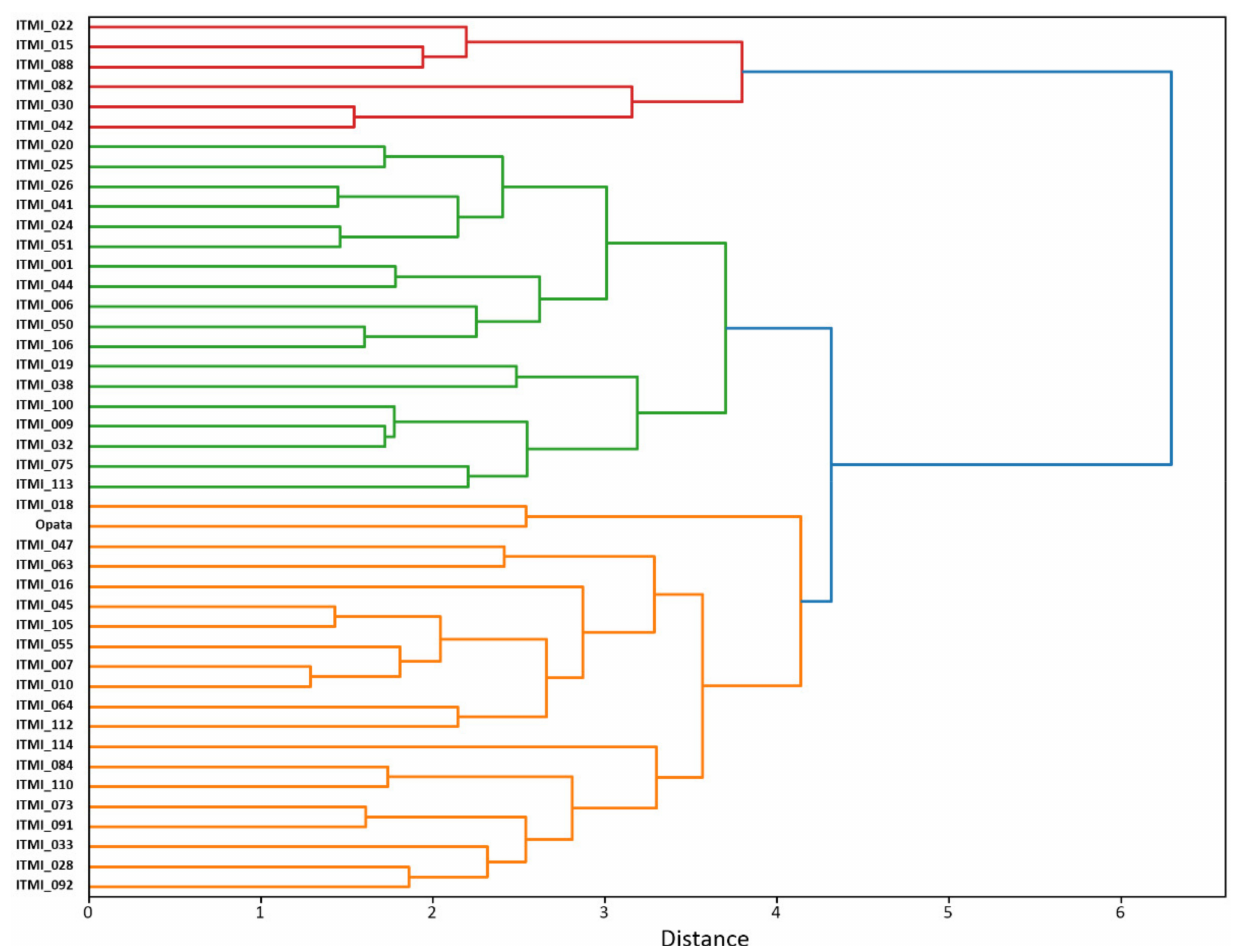
Figure 2. RILs clustering diagram in the space of the grain traits. Three distinct clusters shown by different colors, orange, green and